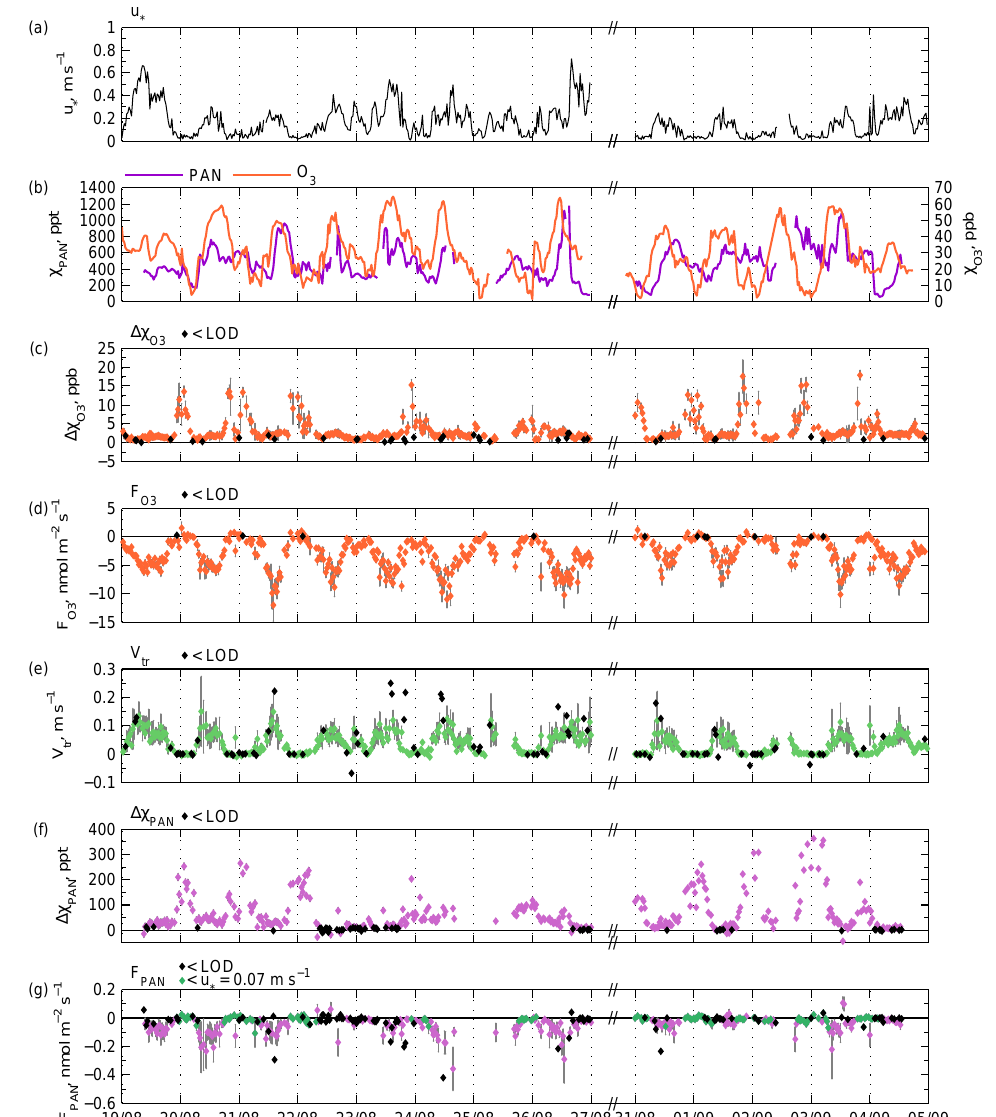
Figure 8. Results from the MBR experiment at the Mainz-Finthen grassland site from 19 August to 4 September 2011 showing (a) u ∗ , (b) PAN and O 3 mixing ratios, (c) 1χ O , (d) F O , (e) v tr , (f) 1χ PAN and (g) F PAN . Grey error bars denote random error. Black data points 3 3 indicate values below the detection limit (for details see text). Red data points denote periods where u ∗ < 0.07ms − 1 .